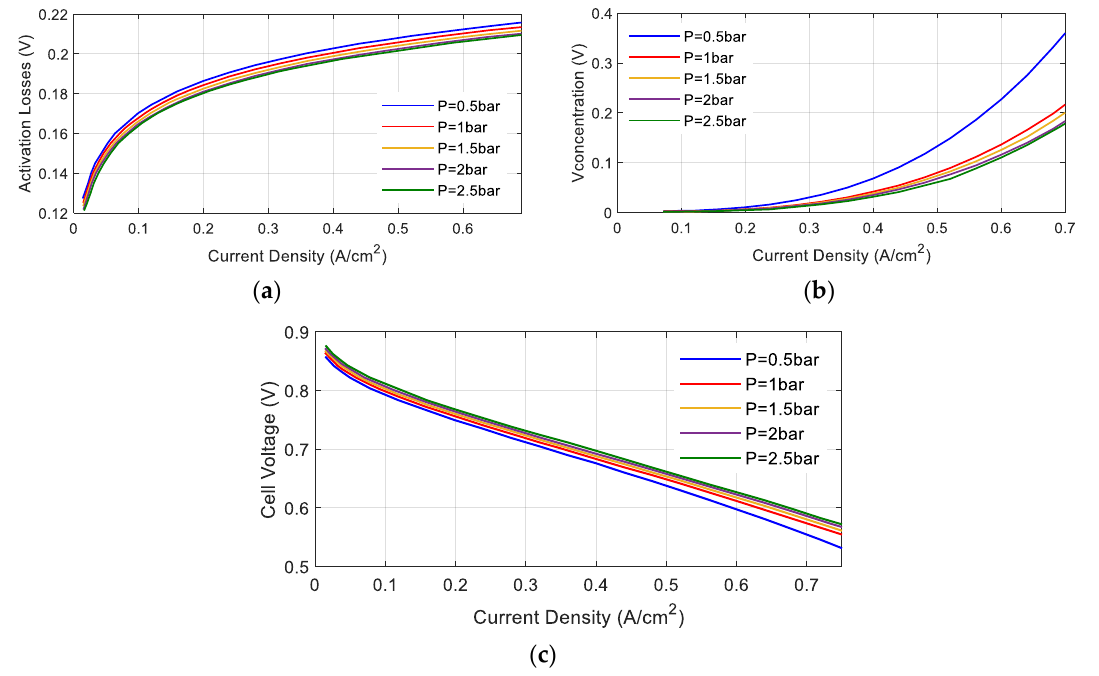
Figure 7. Effect of temperature on ( a ) Activation overvoltage, ( b ) Ohmic overvoltage, ( c ) Concentration losses, ( d ) Cell voltage loss.